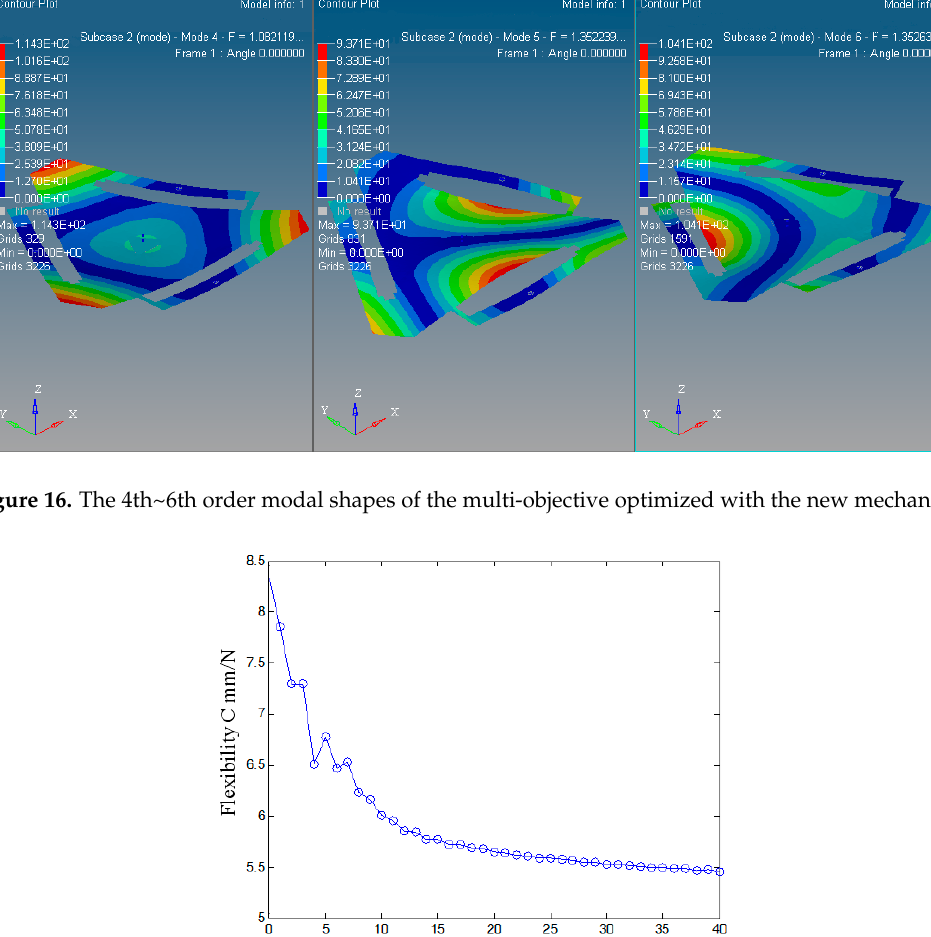
Figure 15. The 1st~3rd order modal shapes of the multi-objective optimized with the new mechanism.